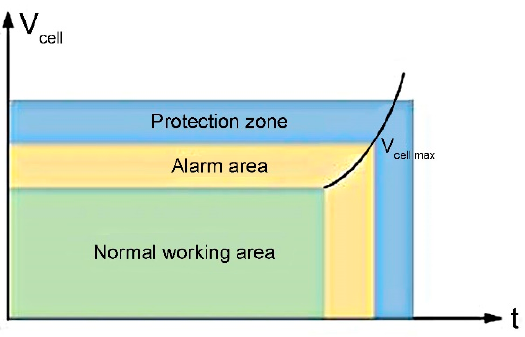
Figure 19. Battery overvoltage protection model.